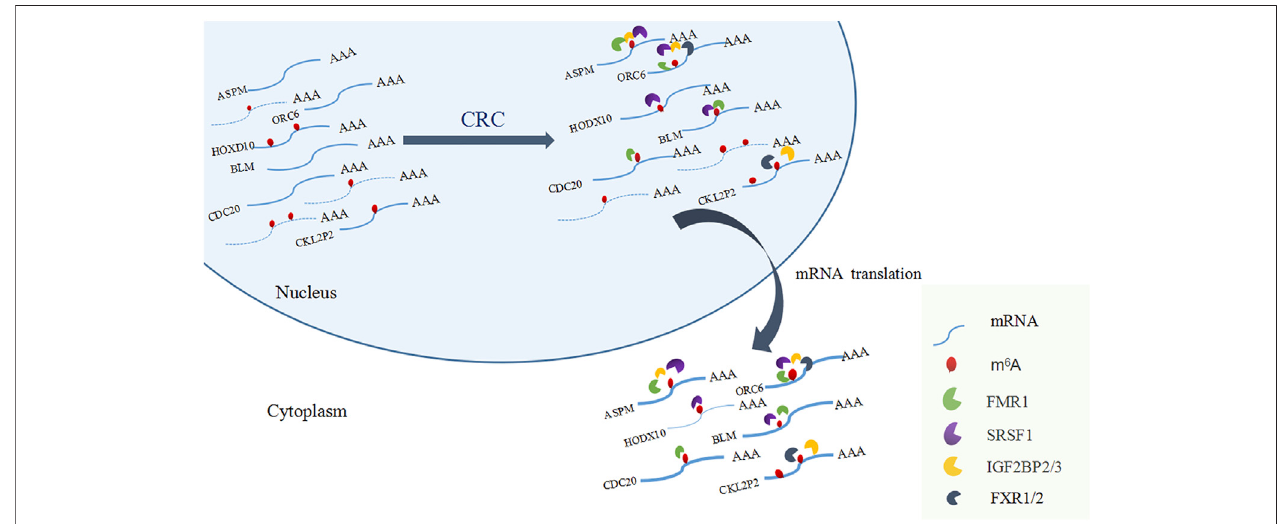
FIGURE 8 | A diagram showing the pattern of m 6 A methylation regulation in